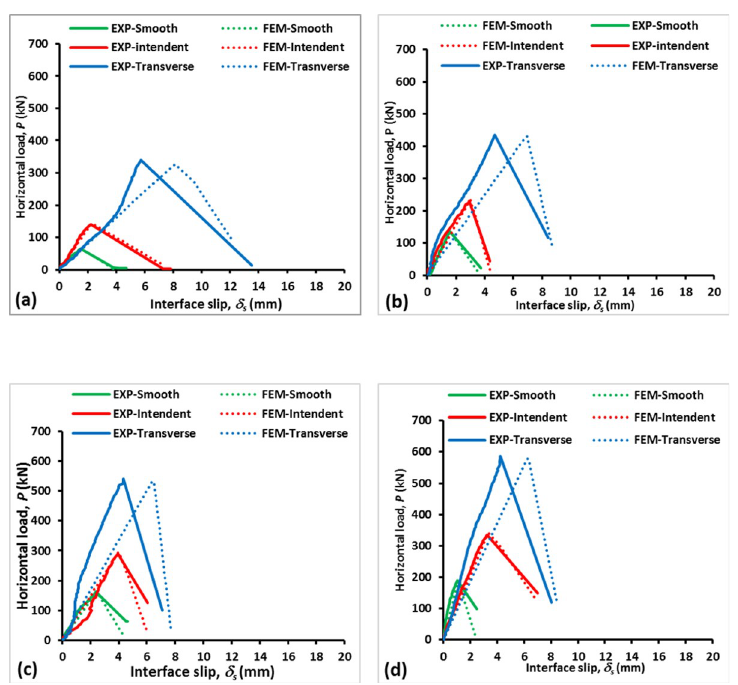
Fig 8. Horizontal load–interface slip relationship under various normal stresses: σ 1.0 N/mm 2 , and (d) 1.5 N/mm 2 .